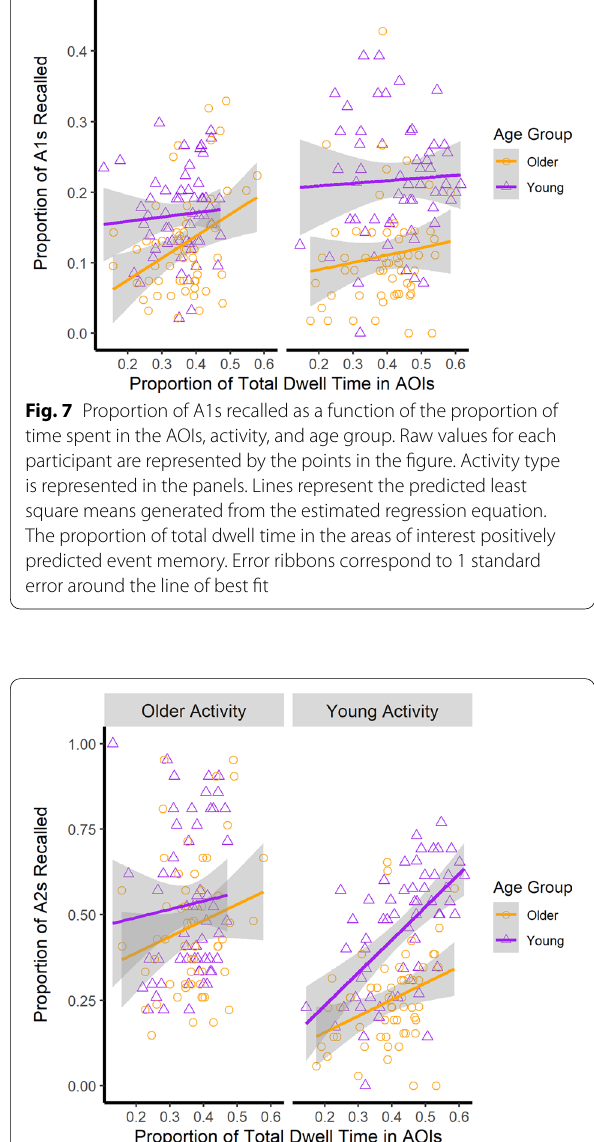
recall memory; however, it did not produce better recog- nition or order memory (see Table 4).